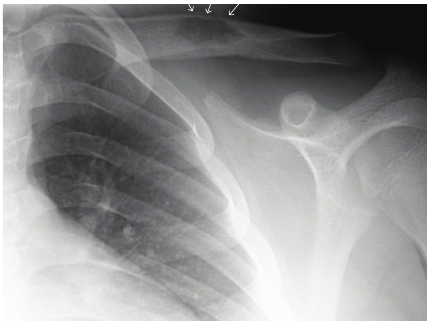
Figure 1: An AP radiograph of the left clavicle in a 13-year-old boy shows a mid-clavicular lytic lesion and subtle periosteal reaction superiorly (arrows). No internal matrix, surrounding sclerosis or soft tissue mass is seen.